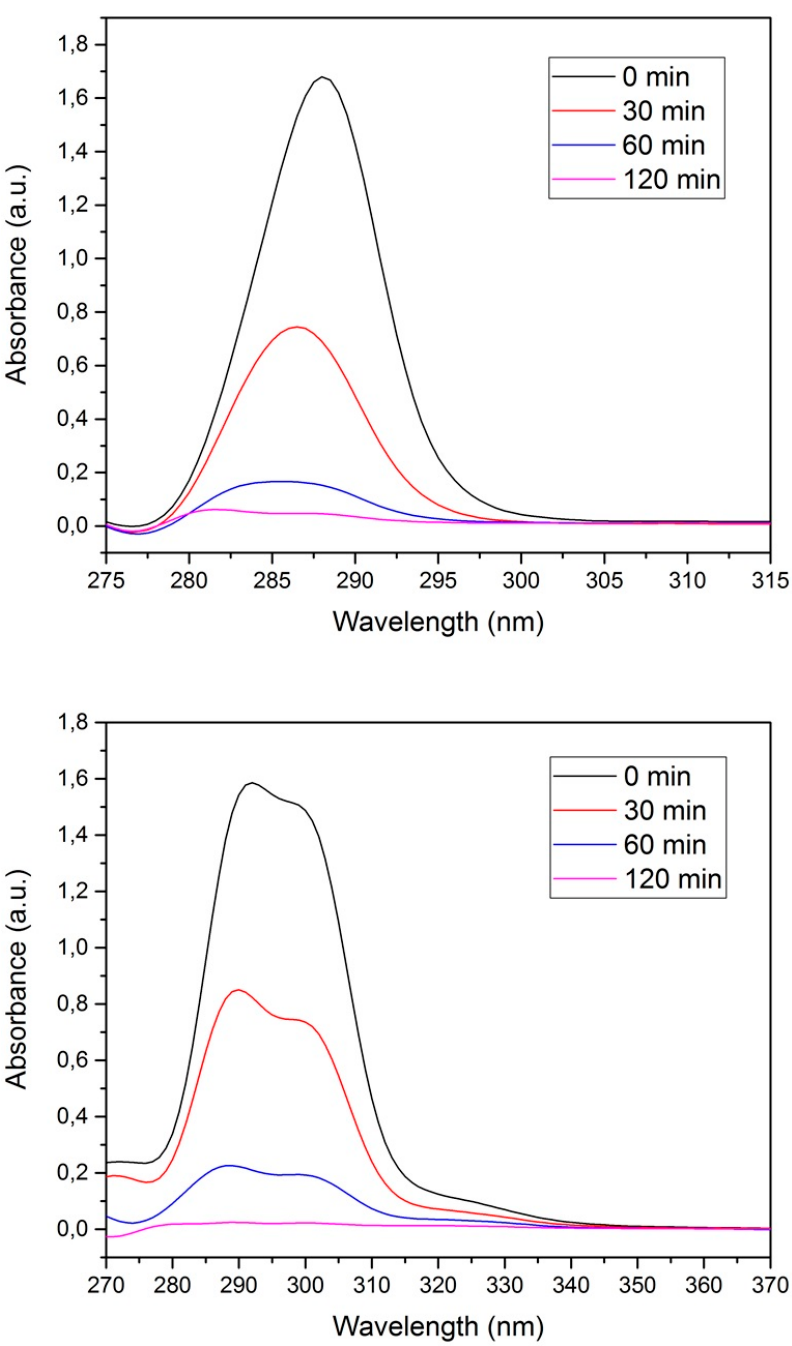
Figure 12. UV–VIS spectra for 4-chlorophenoxyacetic acid (4-CPA) ( upper ) and 2,3,4,6-tetrachlorophenol (TCF) ( lower ) after contact with NS decorated with magnetite.